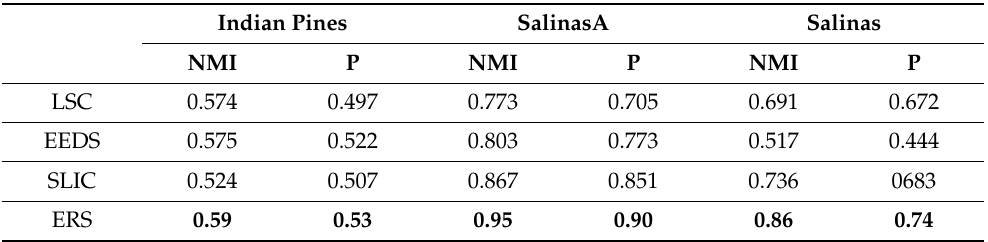
Table 2. Results from various superpixel methods, results in bold highlight the best in the